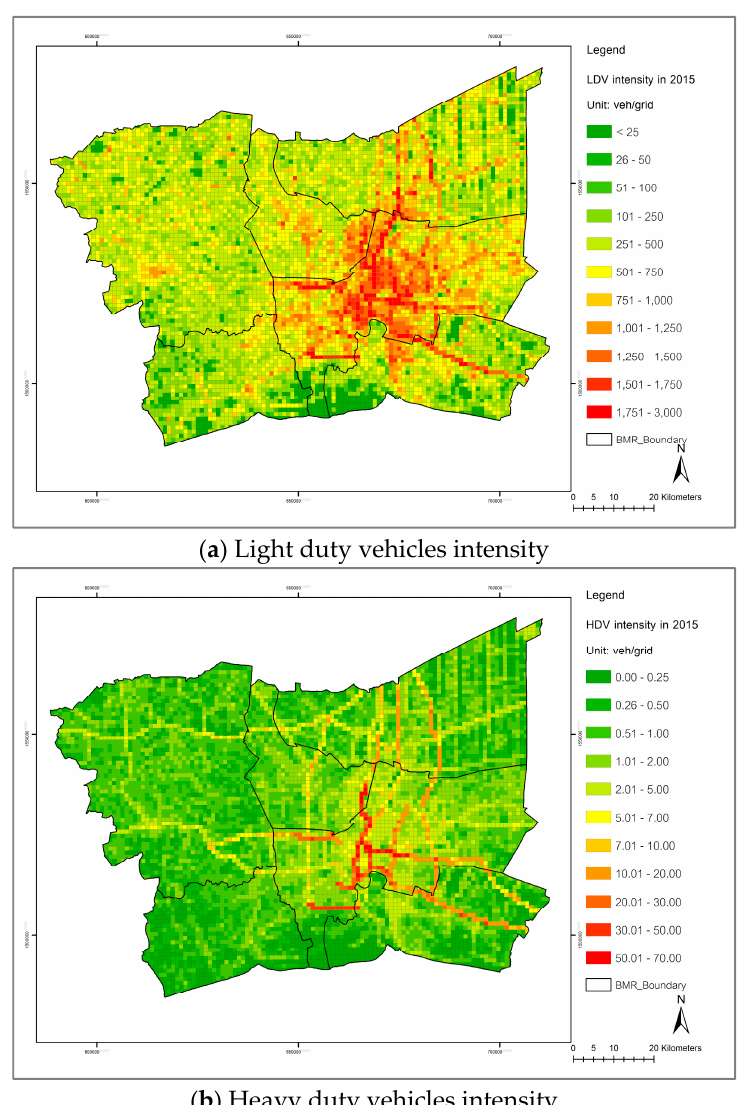
Figure 11. Gridded map of traffic intensity on the road network in the BMR, 2015: ( a ) light duty vehicles intensity; ( b ) heavy duty vehicles intensity.